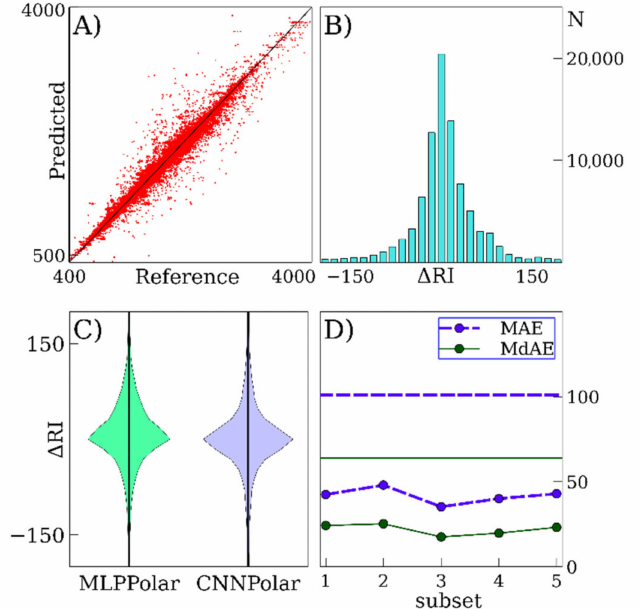
Figure 2. Retention index prediction for polar stationary phases using the NIST 17 database for training and validation. The average of CNNPolar and MLPPolar predictions is considered unless otherwise specified. ( A )—predicted versus reference values for the full database (cross-validation). ( B )—distributions of errors. ( C )—distributions of errors for different deep learning models. ( D )— mean and median absolute errors of prediction for the cross-validation subsets of NIST 17. The horizontal lines denote the results for NIST 05 given in reference [23].